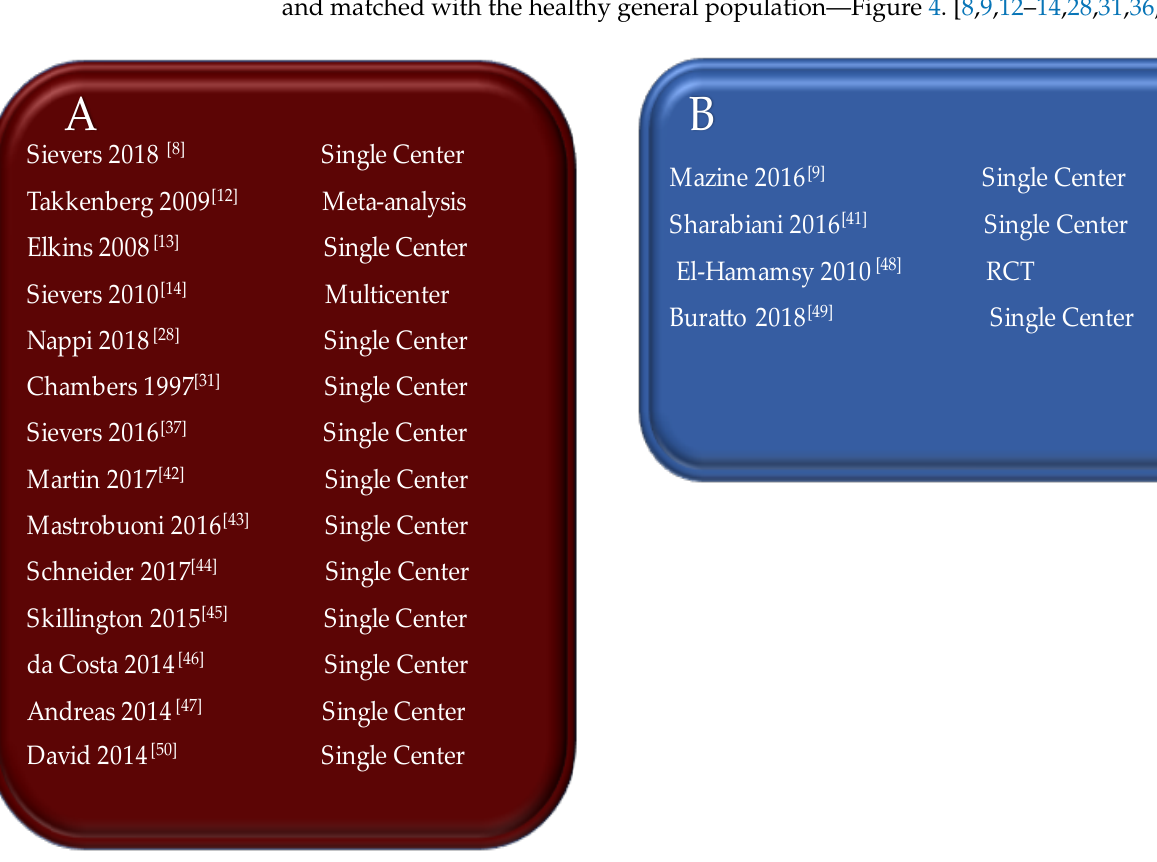
Figure 4. ( A ) Studies reporting long-term outcomes (>15 Years) of the Ross procedure in adult and pediatric populations; ( B ) Studies comparing the Ross procedure to homograft and conventional prosthesis; Abbreviation; RCT, randomized clinical trial. [8,9,13,14,28,31,37,41 – 50].